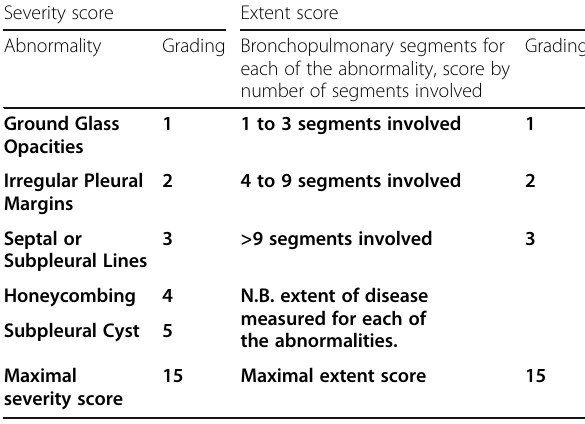
Table 2 Semi-quantitative scoring method: Warrick et al.